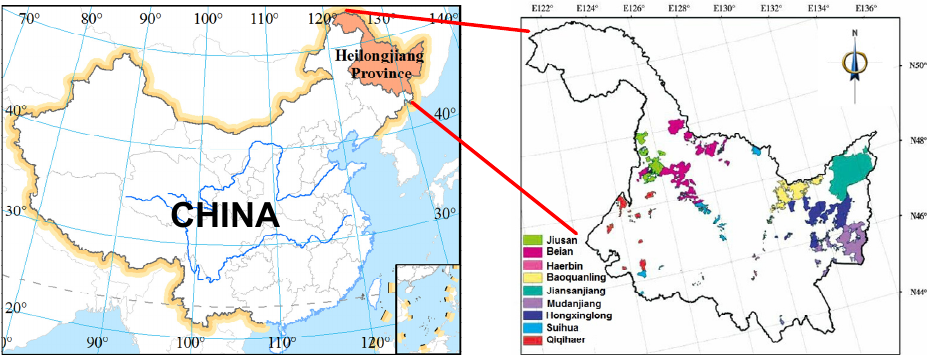
Figure 1. Regional map of the study area.